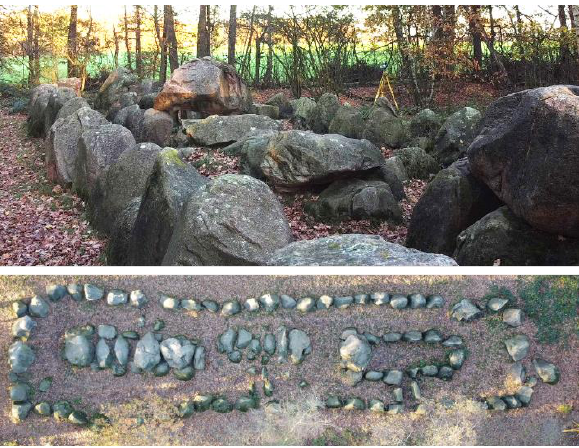
Figure 1: Megalithic tomb "Kleinenknetener Steine II" in current state (top), UAV image of the megalithic tomb